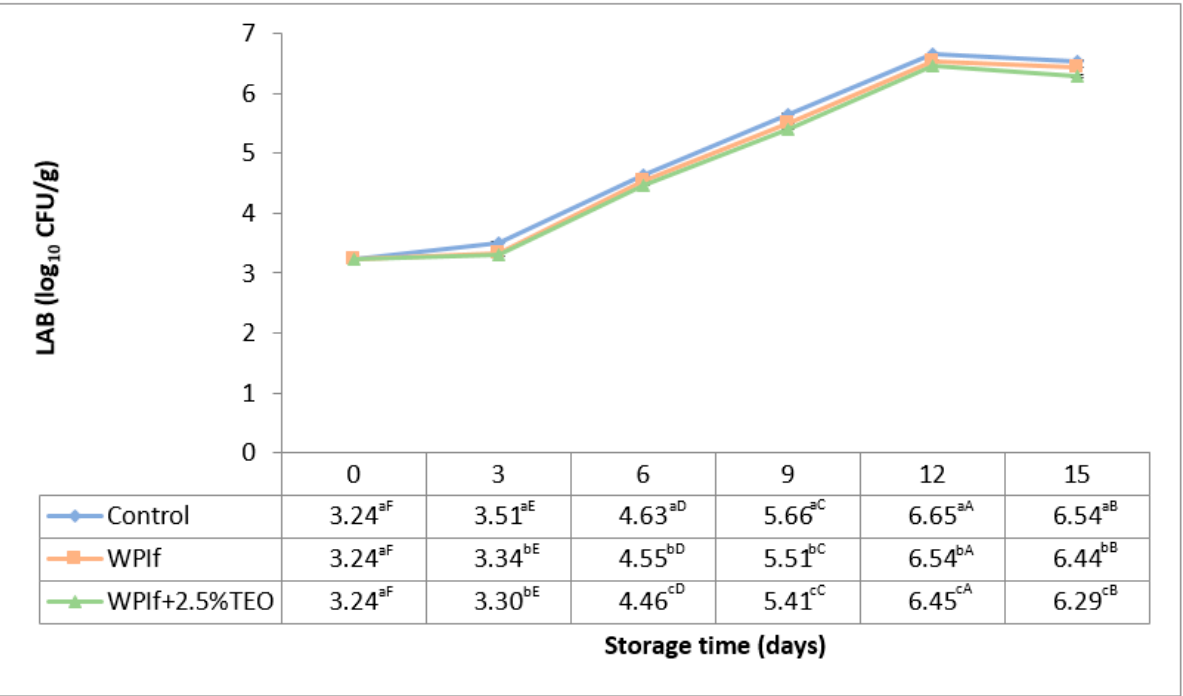
Figure 8. Changes in lactic acid bacteria (LAB) of brook trout samples during refrigerated storage. Control-uncovered fish samples; WPIf-fish samples covered with WPI-based films; WPIf+2.5%TEO-fish samples covered with whey protein isolate-based films incorporated with 2.5% tarragon essential oil. Values are expressed as mean ± standard deviation of two replicates. Means that do not share a letter (lowercase letters on column and uppercase letters on row) are significantly different.